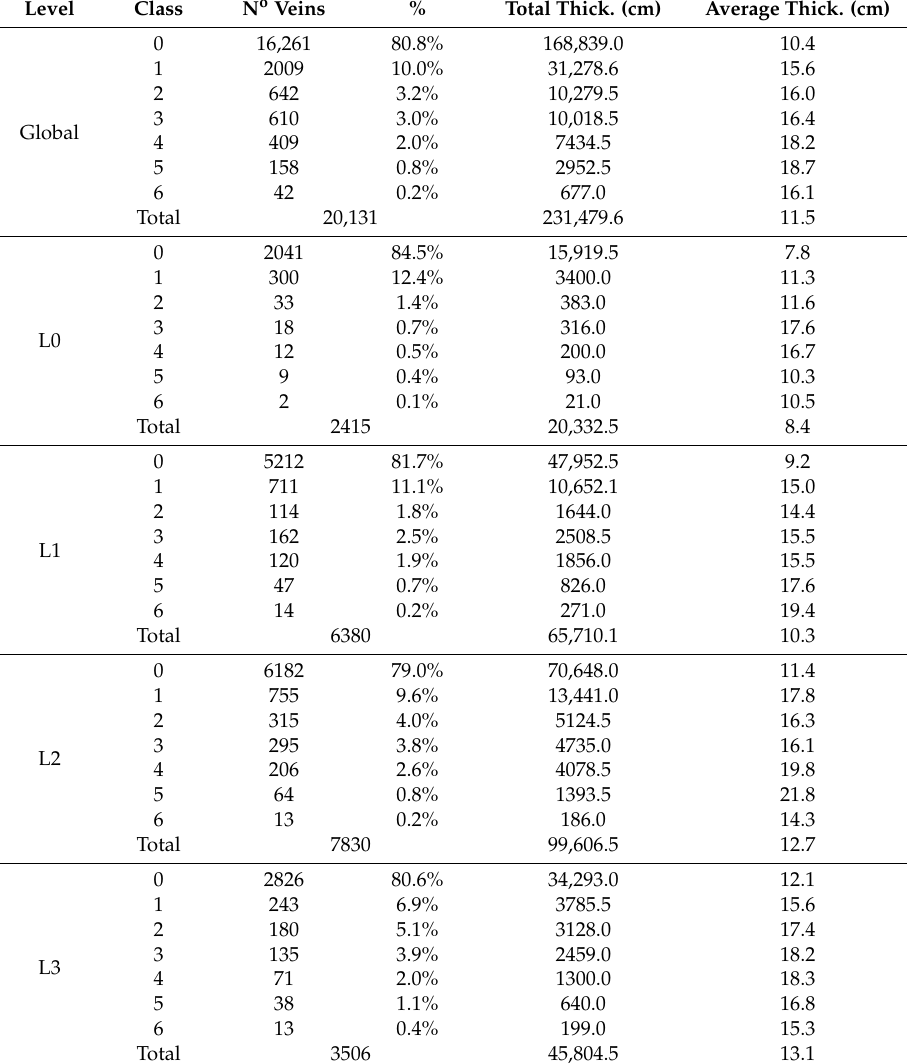
Table A6. Borehole wolframite modal quantity